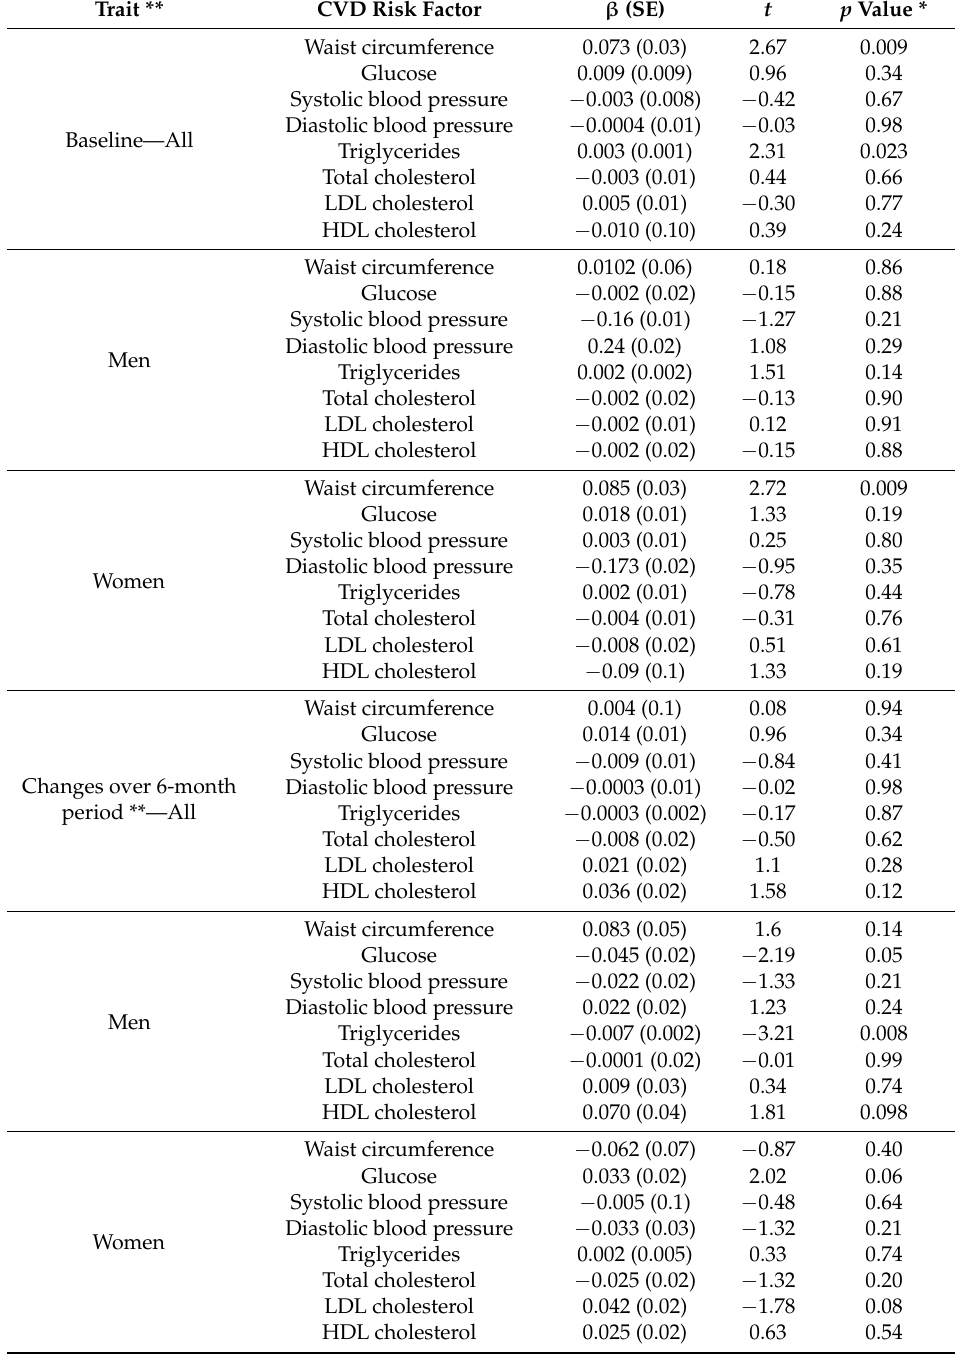
Table 3. Multiple regression analysis of baseline SUA concentrations and changes in SUA concentrations with cardiovascular disease risk